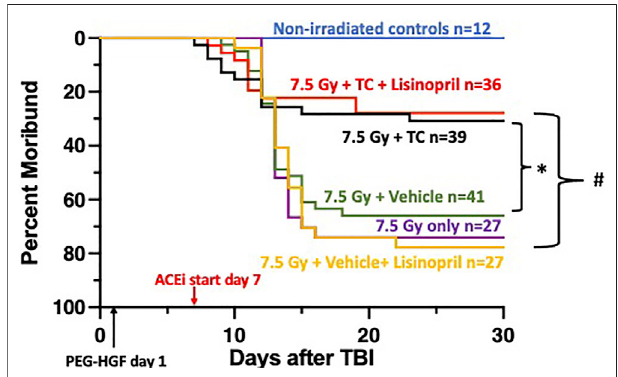
FIGURE 2 | Mitigation of hematopoietic-acute radiation syndrome (H-ARS) by triple combination with and without lisinopril. Kaplan-Meier plots show morbidity through 30-days after 7.5 Gy total body irradiation (TBI). The triple combination (TC, consisting ofPEG-hG-CSF, PEG mGM-CSF and PEG hIL-11) or vehicle were given subcutaneously 24-h after TBI (designated byPEG-HGF)andtheACEinhibitor,lisinopril,wasstartedinthedrinkingwater 7 days after irradiation. The number of rats in each group is designated by the “ n . ” Non-irradiated controls are represented with the blue line. Morbidity was not different in the three irradiated groups given 7.5 Gy only, with vehicle or lisinopril, but survival was enhanced in the group which received the TC ( p (cid:2) 0.05, denoted by * compared to 7.5 Gy + vehicle group). Survival was increased in the irradiated group receiving TC and lisinopril compared to the irradiated rats receiving the vehicle for TC and lisinopril ( p < 0.05, denoted by